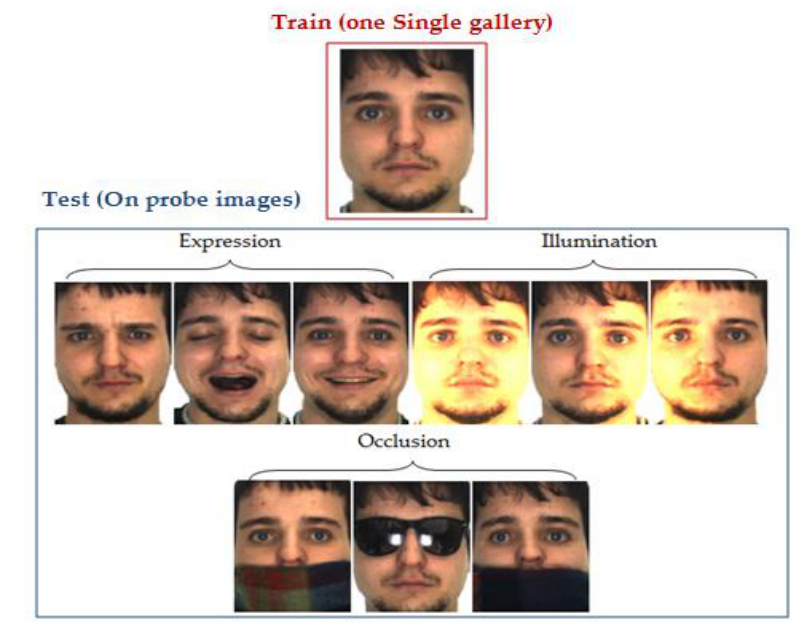
Figure 43. Example of face recognition by single sample per person.